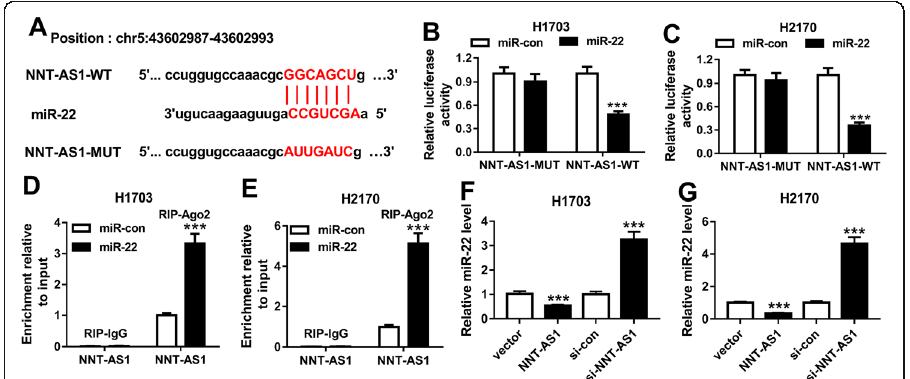
AS1 deletion promoted miR-22 expression in H1703 and H2170 cells (Fig. 2f, g). These data indicated that NNT-AS1 was a sponge of miR-22 and negatively regulated miR-22 expression in LUSC